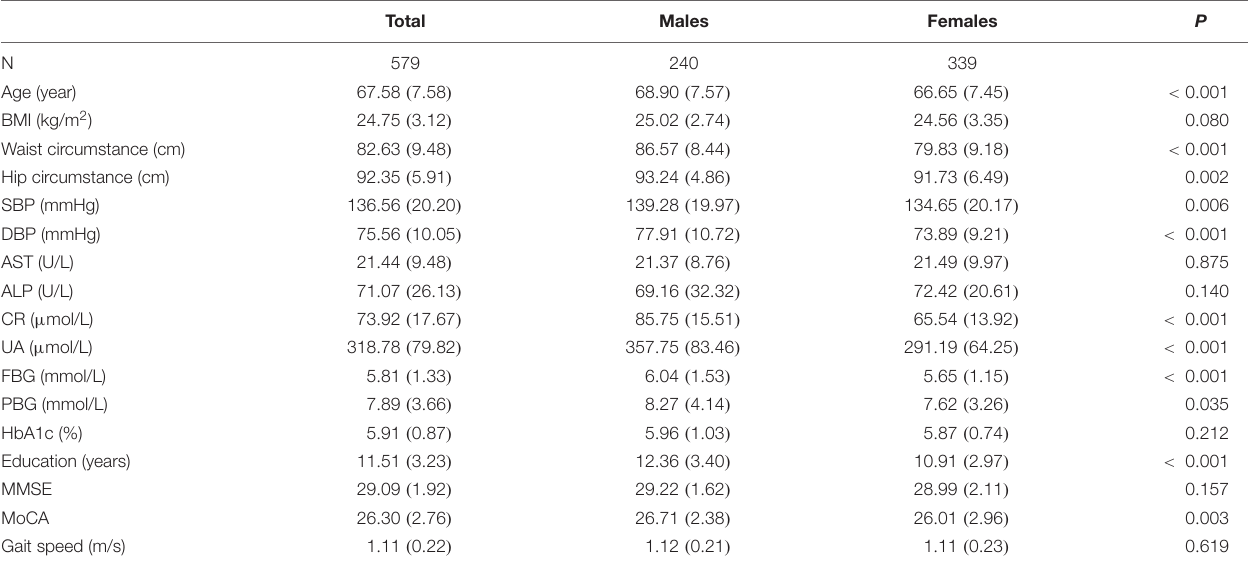
TABLE 3 | Basic characteristics of participants of the Shanghai Changfeng